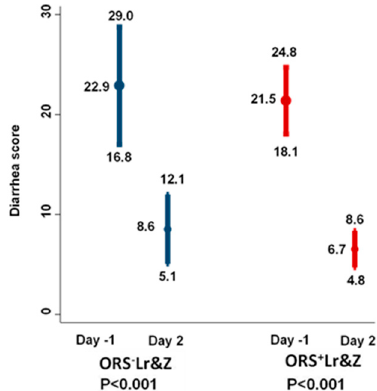
Figure 2. Improvement of the severity score of diarrhoea at day 2 compared to baseline (day − 1 ). At each time point, the results are presented with means and 95% confidence intervals. Comparisons within groups were performed by the Wilcoxon signed-rank test for paired data, whereas data between groups were compared by the Mann-Whitney U test. Comparisons in the ORS + Lr&Z arm on day two versus day − 1 ( p < 0.001). Comparisons in the ORS − Lr&Z arm on day two versus day − 1 ( p < 0.001).